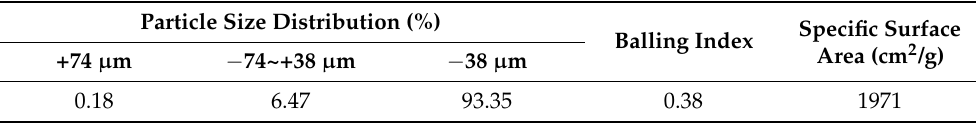
Table 2. Particle size distribution and other properties of